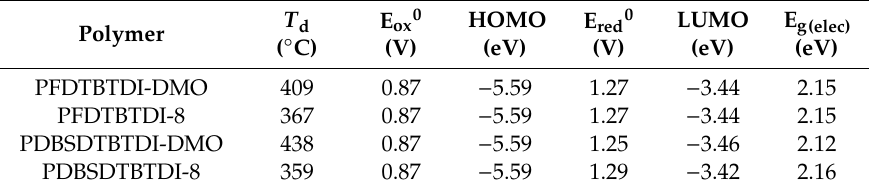
Figure 2. Cyclic voltammograms of ( a ) PFDTBTDI-DMO and PFDTBTDI-8; ( b ) PDBSDTBTDI-DMO and PDBSDTBTDI-8 on Pt electrode in Bu 4 NClO 4 / CH 3 CN at 100 mV / s. Table 3. Thermal and electrochemical properties of the polymers.